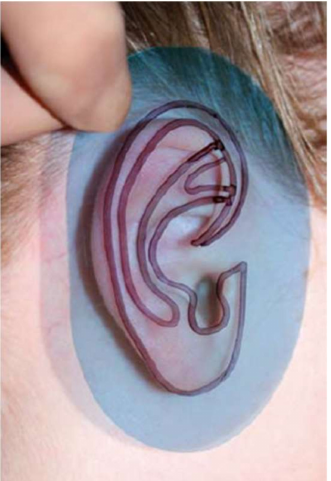
Figure 5. 2D template of the ear. A translucent X-ray film is placed against the opposite ear and the main’s shape features are hand-traced, creating a 2D projection of the 3D